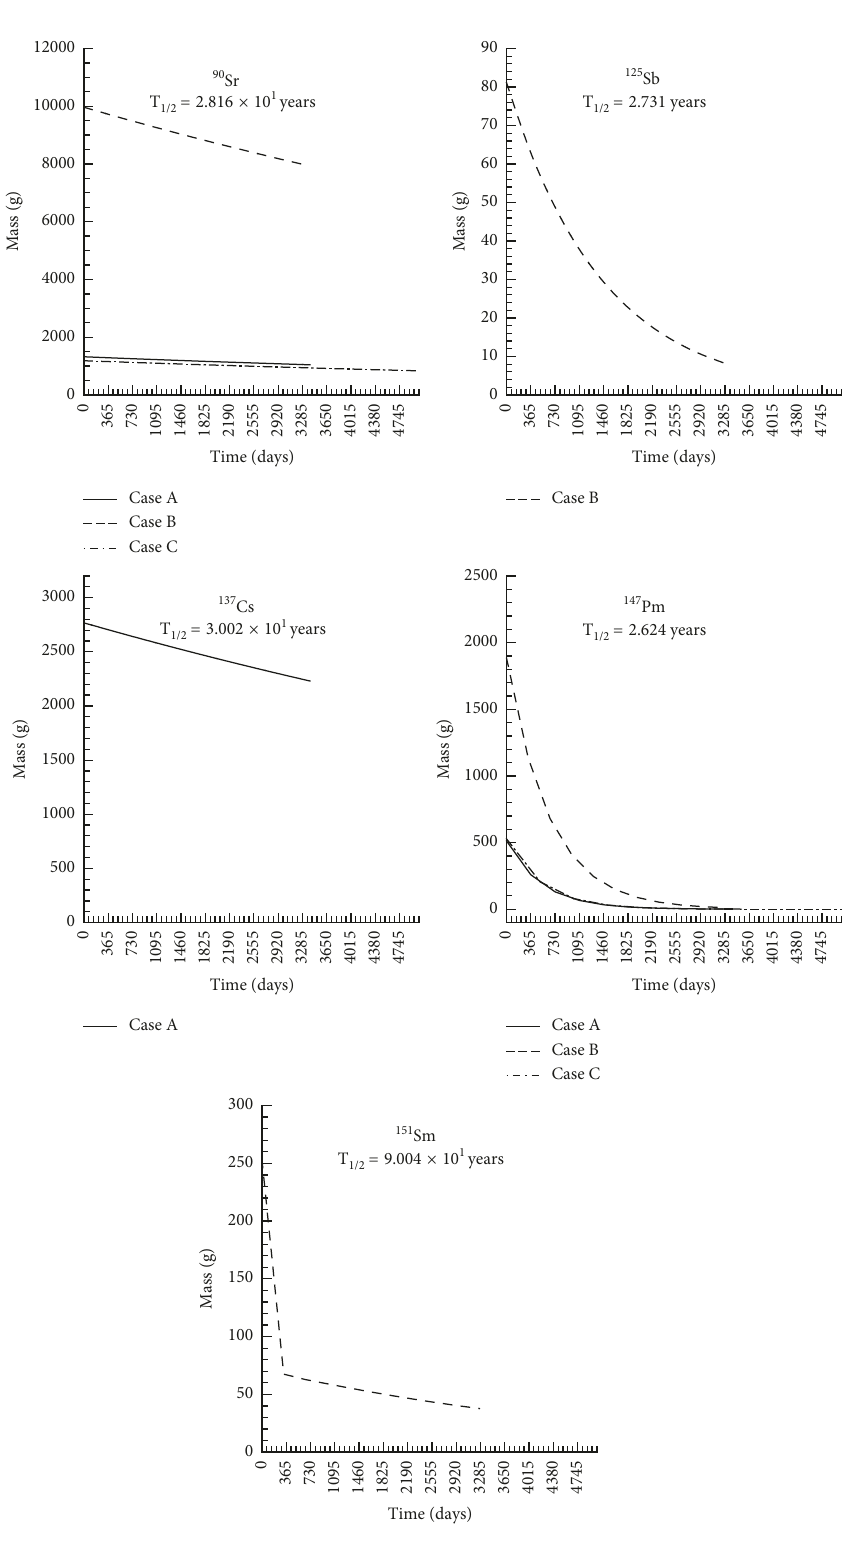
Figure 8: Decrease in masses of MLFPs during the operation